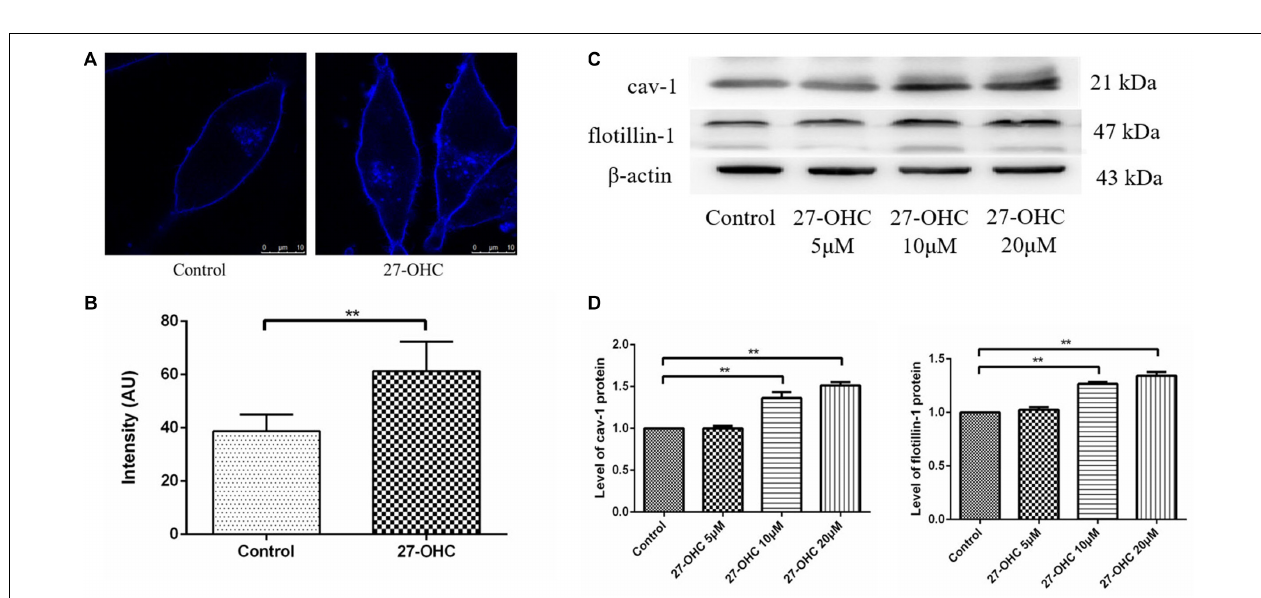
FIGURE 4 | Cell membrane cholesterol assessment in SH-SY5Y cells. (A,B) Cholesterol observation and analysis of the control and 20 µ M 27-OHC group by Filipin III staining under confocal microscope (scale bar: 10 µ m). (C,D) Western blot analysis of cav-1 and flotillin-1 in SH-SY5Y cells after 0, 5, 10, and 20 µ M 27-OHC treatment for 24 h. ** P < 0.01 compared with the control group (one-way ANOVA).